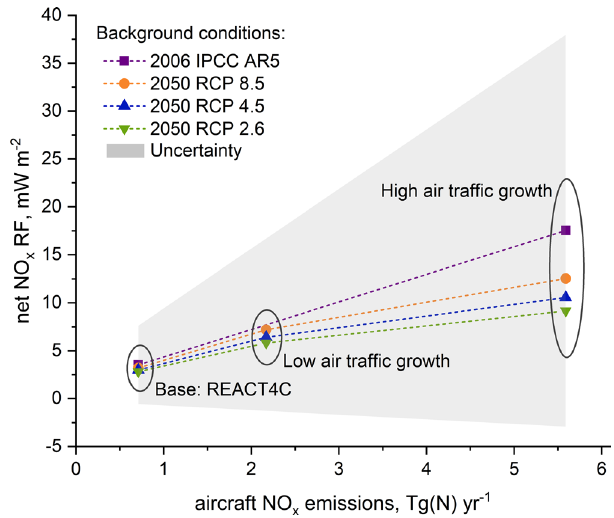
Fig. 1 Net NO x radiative forcing by emission rate, original CH 4 parameterisation. Aviation net NO x radiative forcing (RF) (the sum of the short-term positive O 3 RF perturbation and the negative RF terms caused by a reduction in CH 4 lifetime, see Methods), by aviation NO x emission rate according to a range of background emission scenarios, utilising the IPCC Fifth Assessment Report 59 simpli fi ed expression for the calculation of CH 4 forcing. Aviation net NO x RF systematically increases with increasing NO x emissions from aviation, showing a variation according to the background surface emissions, with high mitigation (RCP 2.6) having a smaller aviation net NO x RF than, lower mitigation scenarios (RCP 4.5, RCP 8.5) for the same aviation NO x emission. Overall uncertainties are indicated by the grey shading, which is one standard deviation (68% con fi dence interval) from the ensemble of 20 NO x studies presented in Supplementary Fig.